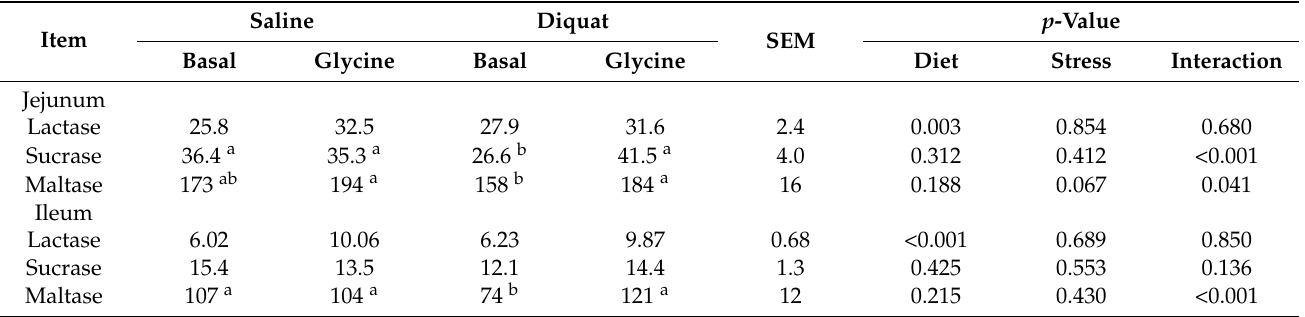
Table 3. The activities of intestinal mucosal disaccharidases of the piglets fed glycine diets under oxidative stress (U/mg